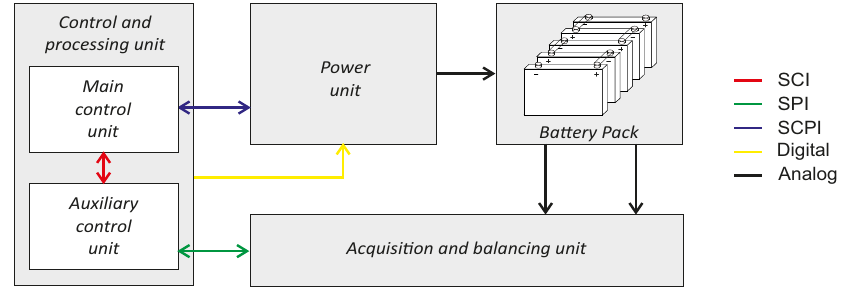
Figure 5. Block diagram of the hardware topology.